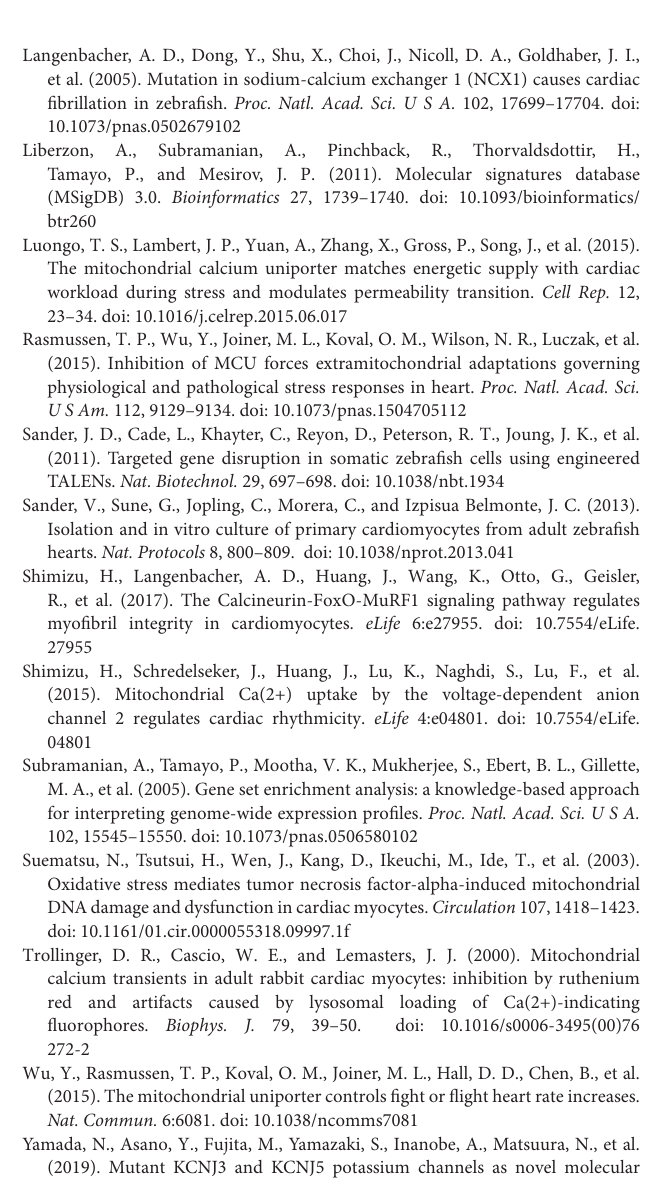
Supplementary Figure 1 | Quantitative PCR analysis of expression of selected genes in adult WT and MCU mutant hearts. Supplementary Movie 1 | Explanted zebrafish heart. Supplementary Movie 2 | Explanted zebrafish MCU mutant